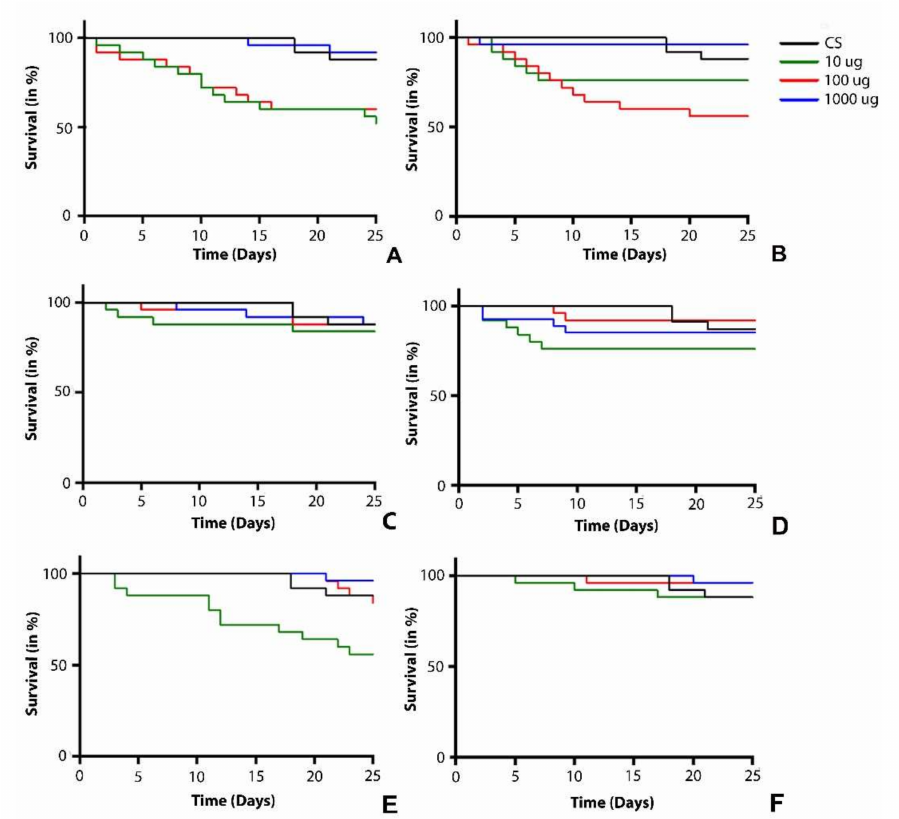
Figure 4. Survival assay curve of male flies treated with mesoporous carbon nanoparticles ( A ) CNS500, ( B ) CNS600, ( C ) CNS700, ( D ) CNS800, ( E ) CNS900, and ( F ) CNS1000 at 10, 100, and 1000 µ g/mL doses, respectively. Here, the black curve represents the survival rate of control flies. The blue, red, and green curves represent the survival rates of male flies at 10, 100, and 1000 µ g/mL doses,